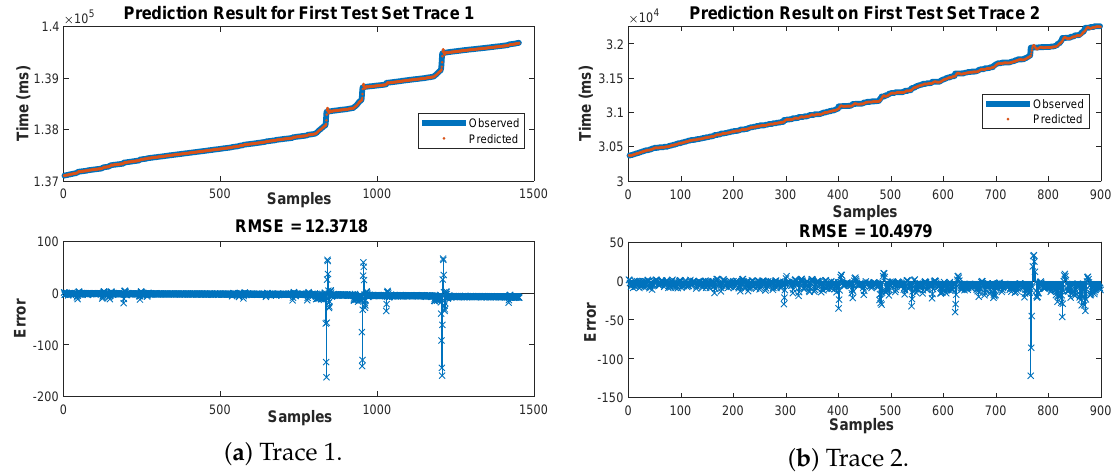
Figure 8. Prediction result and root mean square error (RMSE) for first test